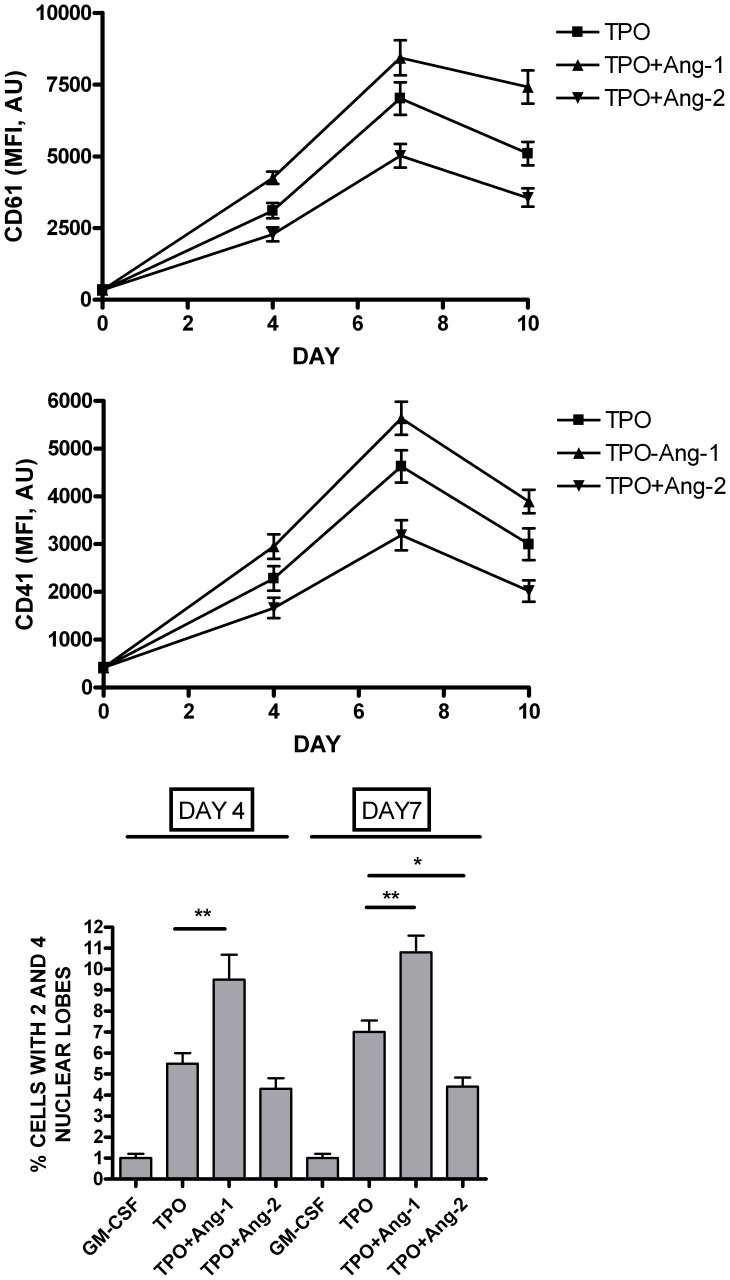
Effect of exogenous Ang-1 and Ang-2 on TPO-driven Mk differentiation of UT7/mpl cells.UT7/mpl cells have been grown in the presence of TPO alone or in combination with either Ang-1 or Ang-2 and at various days of culture the expression of CD61 (Top Panel) and CD41 (Middle Panel) antigens by flow cytometry and the percentage of polylobated (i.e., with 2 or 4 nuclear lobes) nuclei was evaluated by microscopy inspection of individual MGG-stained cells (Bottom Panel). The data represent mean values ± SEM observed in three separate experiments. In the top and middle panels the difference between TPO and TPO+Ang-1 or TPO+Ang-2 was significant (p<0.05). * p<0.05; ** p<0.01.